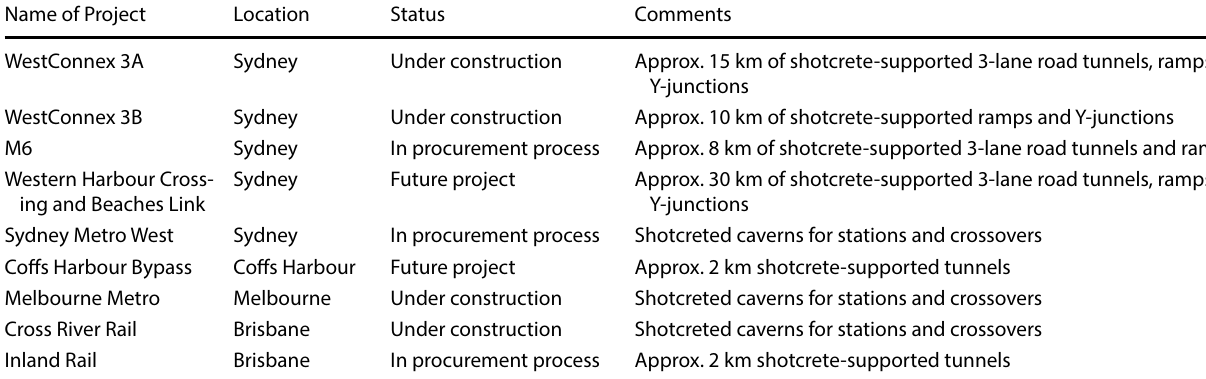
Table 1 Infrastructure projects in Australia with significant shotcrete lined